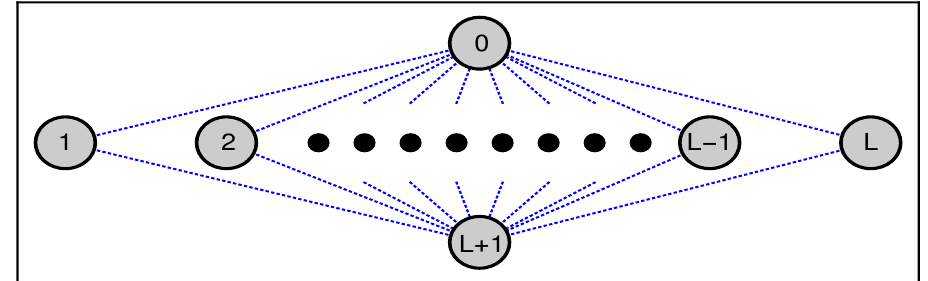
Figure 2: In this figure the type of interaction among fermions at different sites, for A = B = 0 is demonstrated. As one can see, there is no particle hoping among sites 1 to L and the only allowed hoping is from sites 0 or L + 1 with the rest of